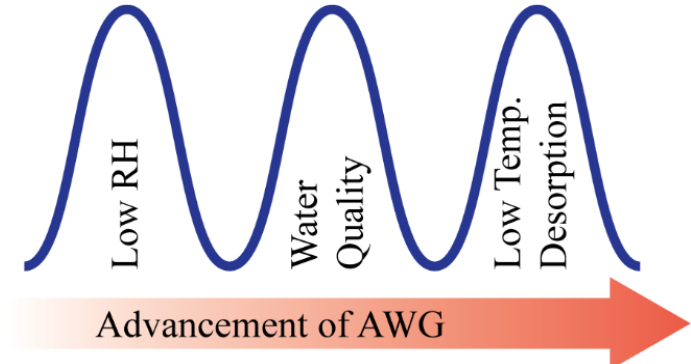
Figure 1. Barriers to the progress of AWG technology.